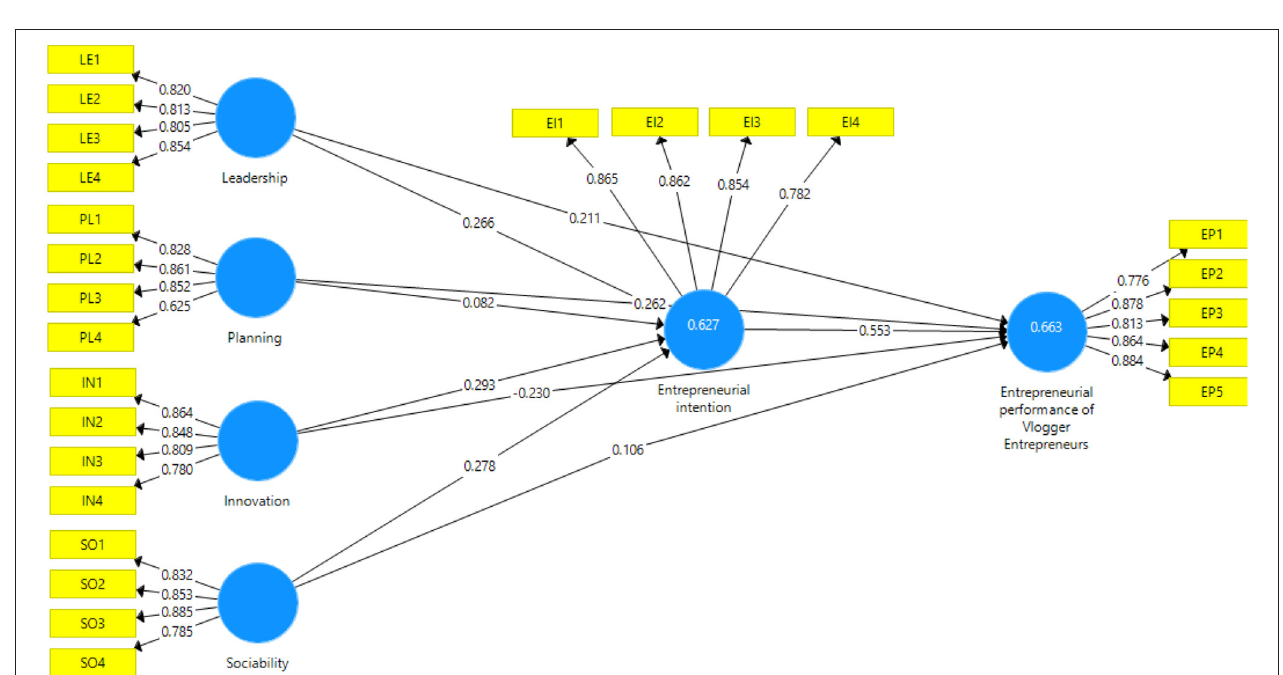
FIGURE 2 | SmartPLS algorithm